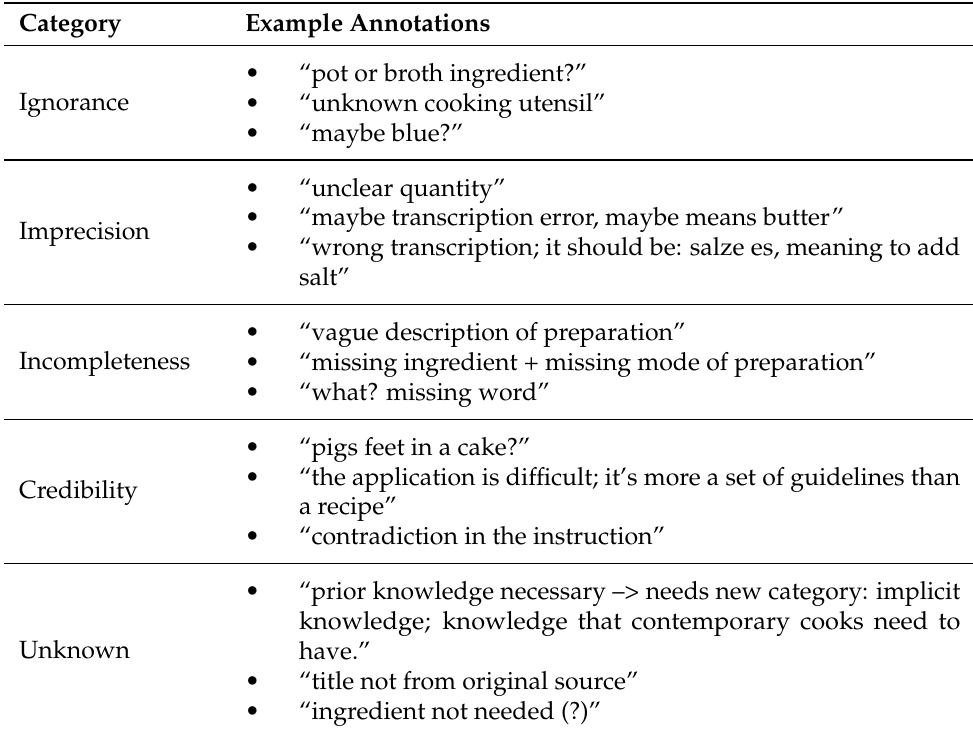
Table 2. Example annotation text for each uncertainty category (translated into English from